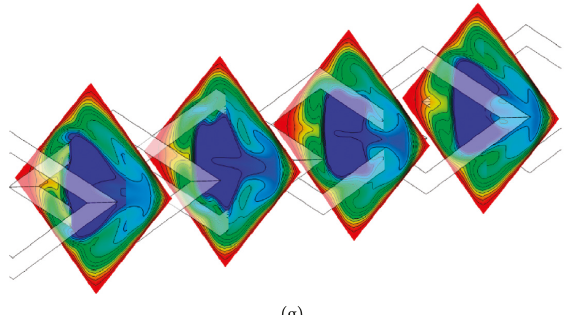
Figure 8: Temperature contours in the y - z plane of the heat exchanger square duct installed with the 45 ° ISR for (a) s / H � 0, (b) s / H � 0.05, (c) s / H � 0.10, (d) s / H � 0.15, (e) s / H � 0.20, (f) s / H � 0.25, and (g) s / H � 0.30 at BR � 0.20 and Re �